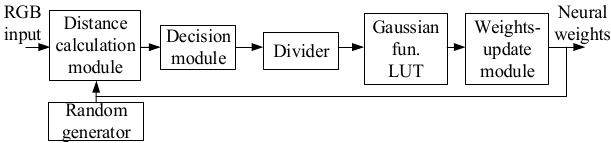
Figure 6. System architecture of the SOM training module.